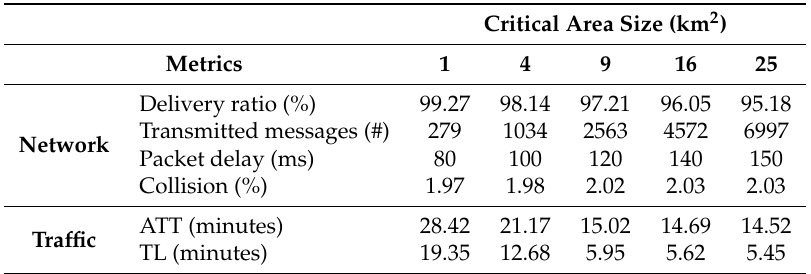
Table 6. Network and traffic efficiency metrics according to the size of the critical